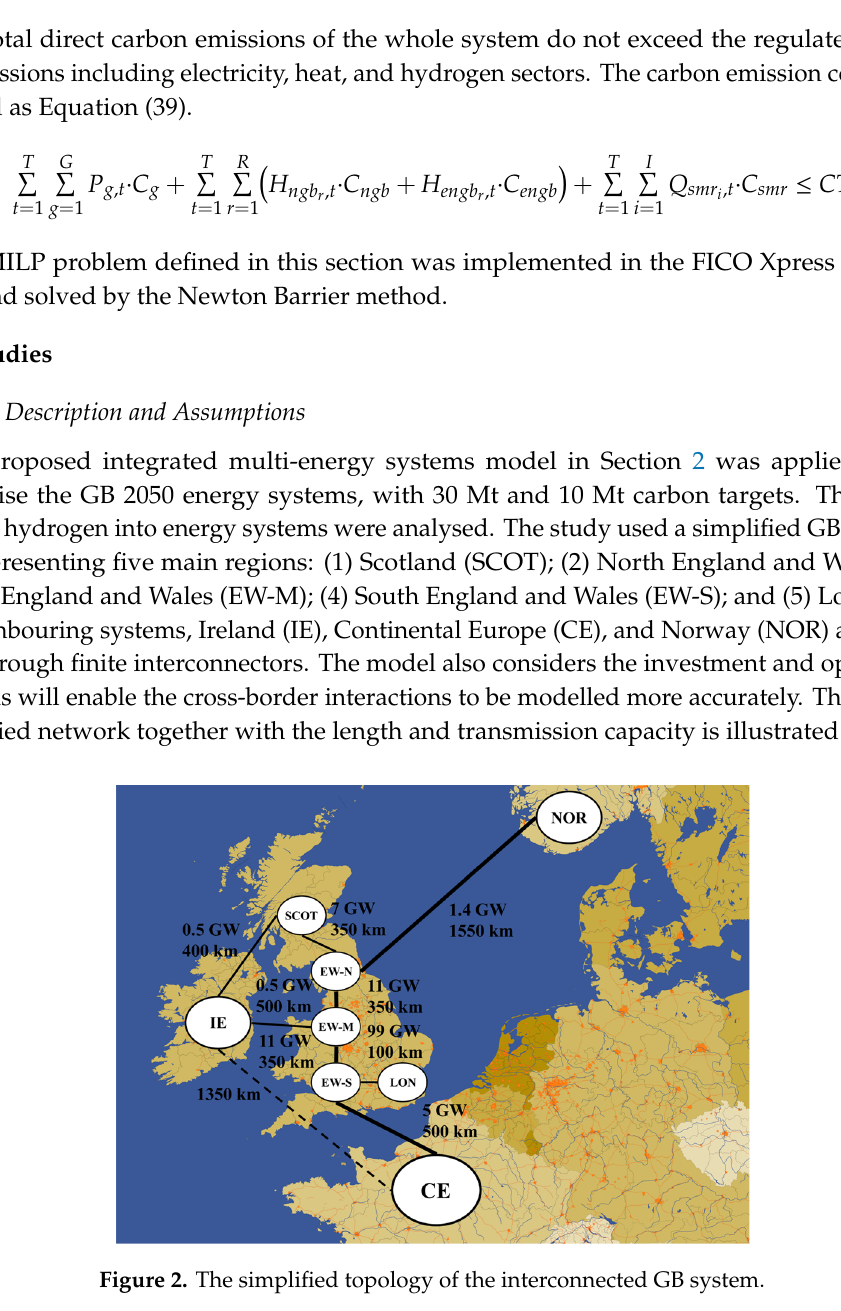
Table 1. Economic and operational parameters of the generation units.